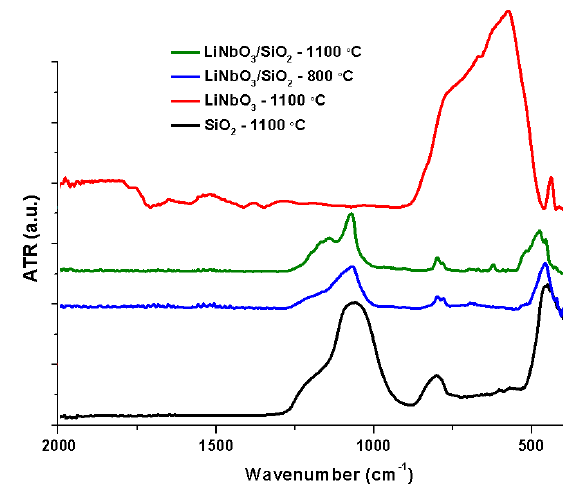
Figure 3. The infrared spectrum of the LiNbO 3 /SiO 2 coaxial fibers.